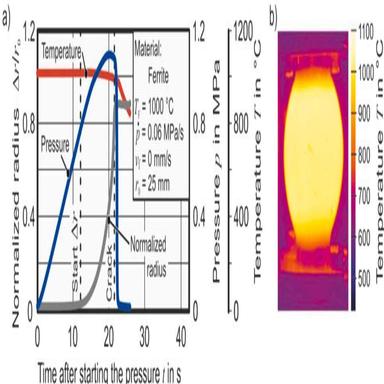
a) Normalized radius Δr/r, pressure p and temperature T as function of time t after the pressure increase occurs and b) temperature distribution T(z,r) during the hot-tube-bulge test.